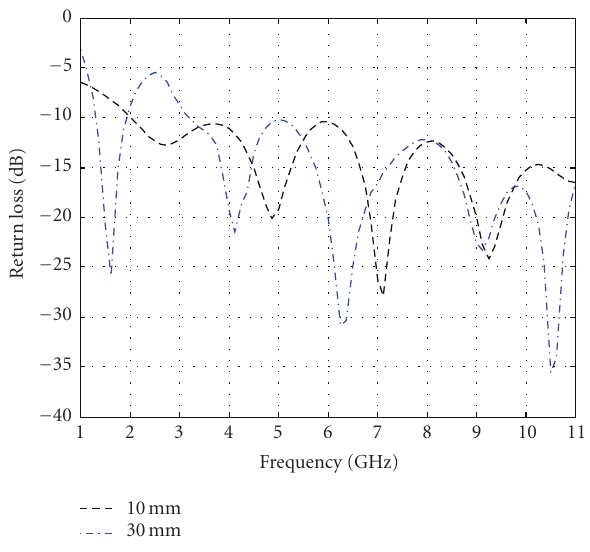
Figure 9: Variation of the simulated mutual coupling with the dis- tance between the antennas at di ff erent frequencies.